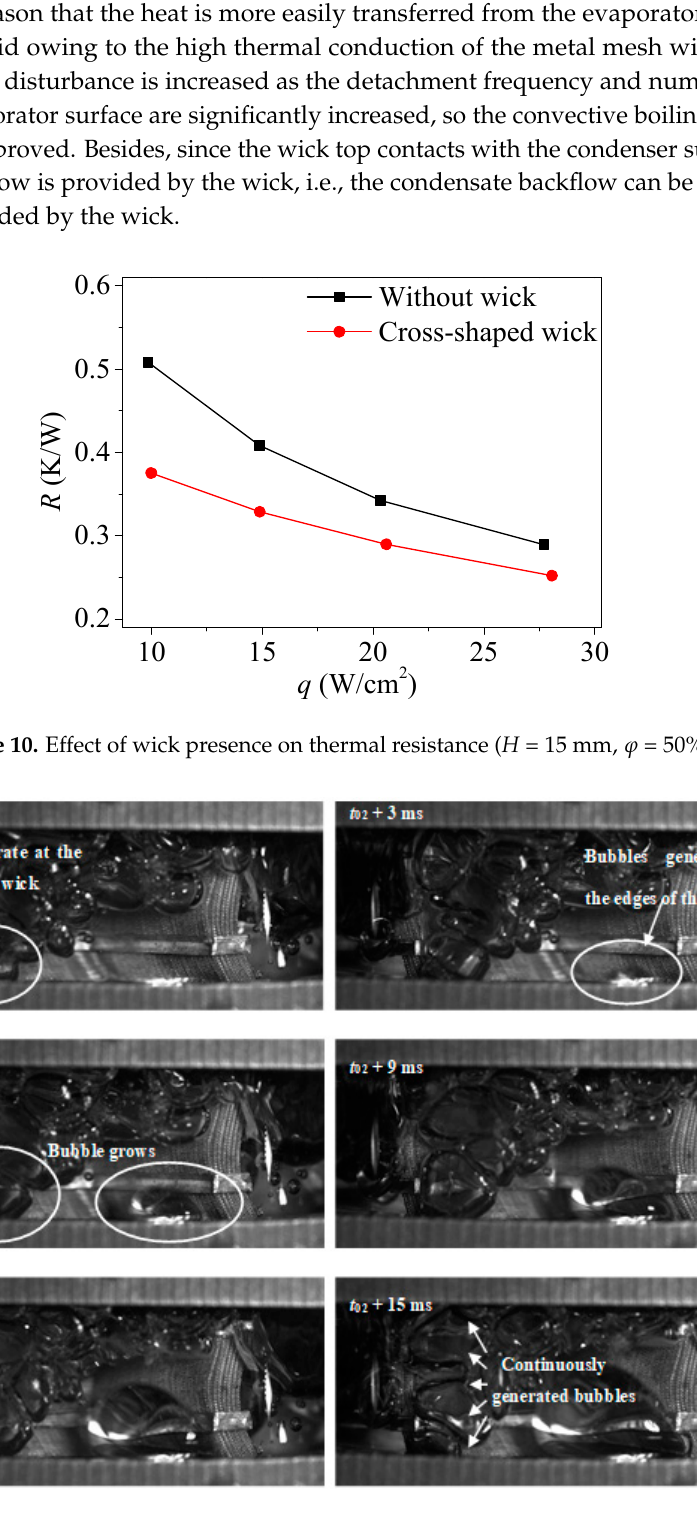
Figure 11. Evolution of vapor–liquid two-phase flow inside the wick thermosyphon ( H = 15 mm, φ = 50%, q = 20 W/cm 2 )